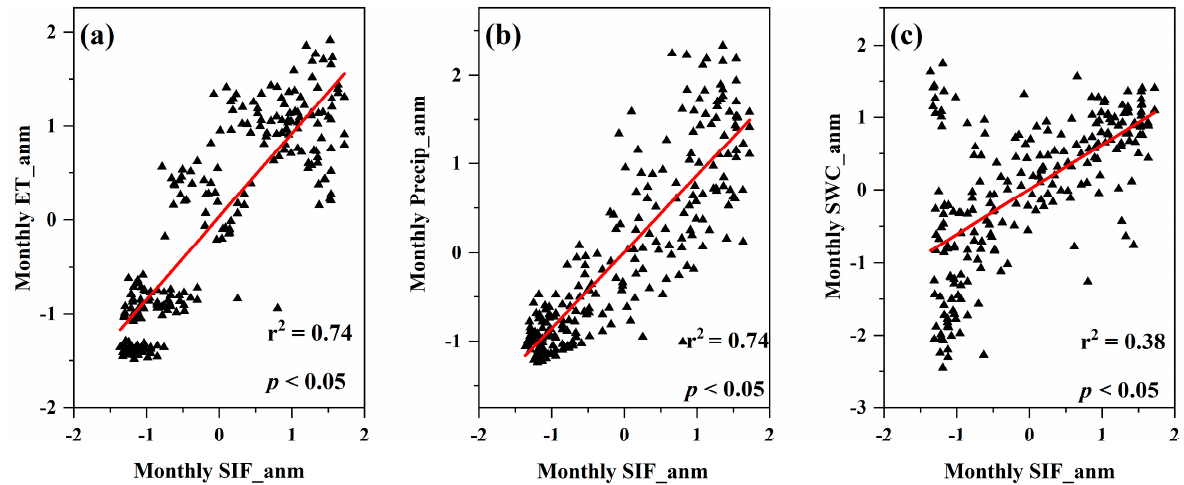
Figure 7. Relationships between SIF anomalies and drought indicators: ( a ) monthly SIF anomalies and P anomalies, ( b ) monthly SIF anomalies and ET anomalies, ( c ) monthly SIF anomalies and SWC anomalies. The correlation coefficients (R 2 ) and p values are provided in each figure.